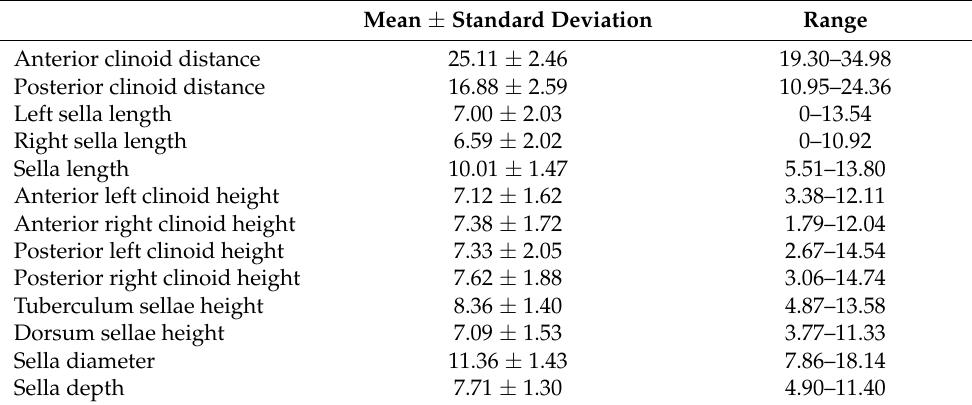
Table 3. The mean and standard deviation of sella turcica dimensions.